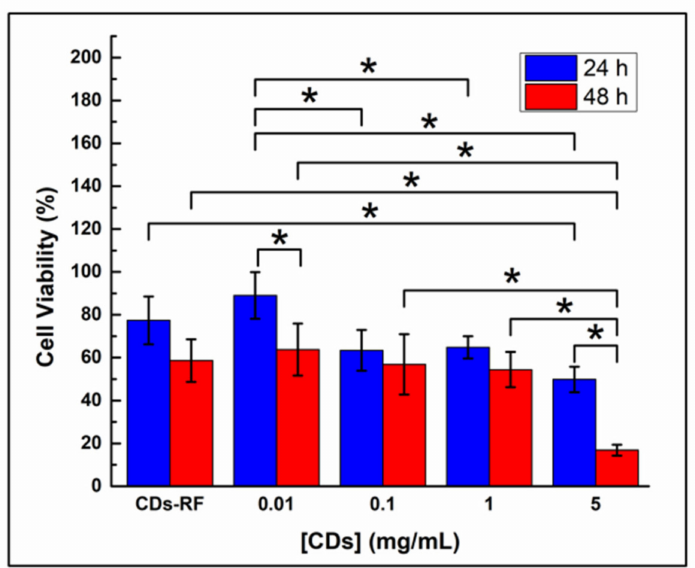
Figure 7. Viability of breast cancer cells (MDA-MB-231) after exposure to CDs at varying concen- trations and a CDs–RF conjugate for 24 and 48 h. All samples were dissolved in PBS. The CDs–RF conjugate was prepared upon the 1:1 mixing of CDs (0.01 mg/mL) and RF (7.44 × 10 − 5 M) solutions. (The concentration of the CDs–RF conjugate was calculated this way to match the conditions of the sensing experiments at the resulting 2 × -dilution after administration to cells). Statistically significant difference between data ( p < 0.05) is denoted with